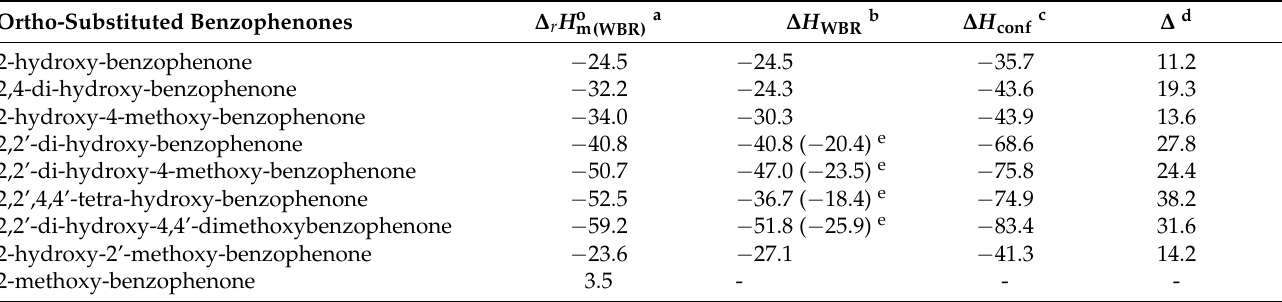
Figure 11. Determination of the intra ‐ molecular hydrogen bonding strength in 2 ‐ hydroxy ‐ benzo ‐ phenone using the “ well ‐ balanced reaction ” method. The reaction enthalpy ∆ (cid:2928) (cid:1834) mo (WBR) = − 24.5 kJ ∙ mol − 1 (see Table 10, column 2). The intra ‐ HB ‐ strength Δ H WBR = − 24.5 kJ ∙ mol − 1 (see Table 10, column 3). The enthalpies of well ‐ balanced reactions (9 to 14) are given in Table 10, column 2. Table 10. Strength of intra ‐ molecular hydrogen bonding (intra ‐ HB) in ortho ‐ substituted benzophe ‐ nones at T = 298.15 K ( p° = 0.1 MPa, in kJ ∙ mol − 1 ).